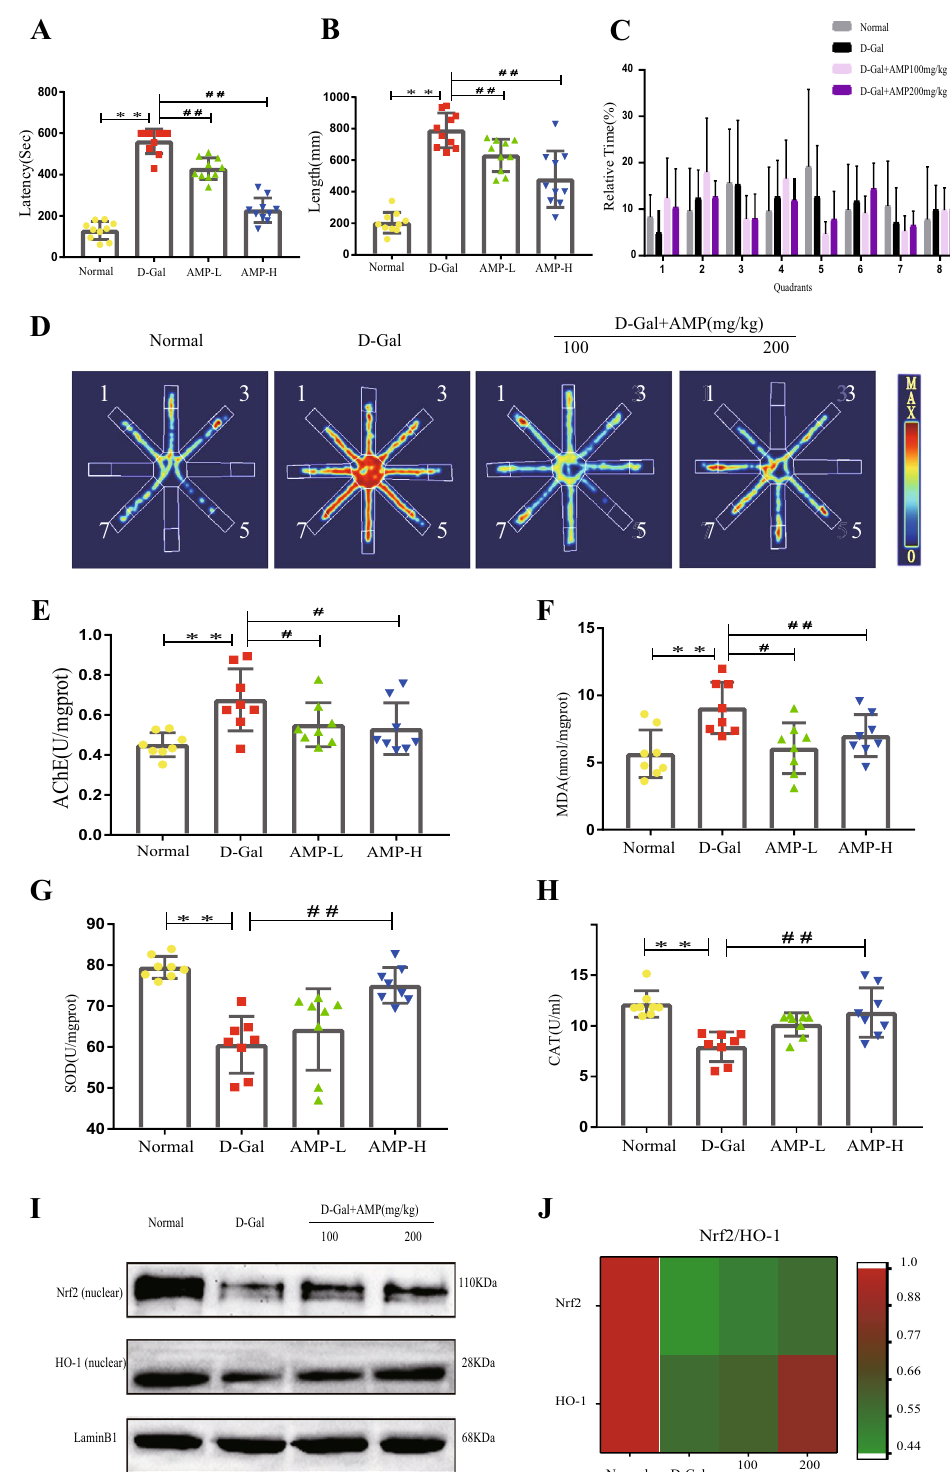
Figure 3. AMP improves D-Gal-induced spatial learning and memory. ( A , B ) Latent period and track length of mice in the maze. ( C ) Percentage of time spent by mice in each quadrant. ( D ) Action trajectory diagram of mice in the maze. ( E ) AchE level in mouse brain tissue. ( F – H ) The brain levels of MDA, SOD, and CAT in D-Gal-induced senescence. ( I , J ) Nrf2 and HO-1 protein expression and heat map analysis of Nrf2 and HO-1 protein expression levels. Data are expressed as the mean ± standard deviation (S.D), n = 10. *p < 0.05 or **p < 0.01 vs. normal group; # p < 0.05 or ## p < 0.01 vs. D-Gal group. The figures were created by using GraphPad Prism Software version 6.04 (https:// www. graph pad. com/). Chemical imaging was collected using Bio-Rad Imaging System version VersaDoc 3000 (https:// www. bio- rad. com/). The heatmap was constructed using the online tool Morpheus (https:// softw are. broad insti tute. org/ morph eus/). Trajectory imaging was taken using Thermal Imaging Analysis software version RMT-100 (https:// tmvmc.